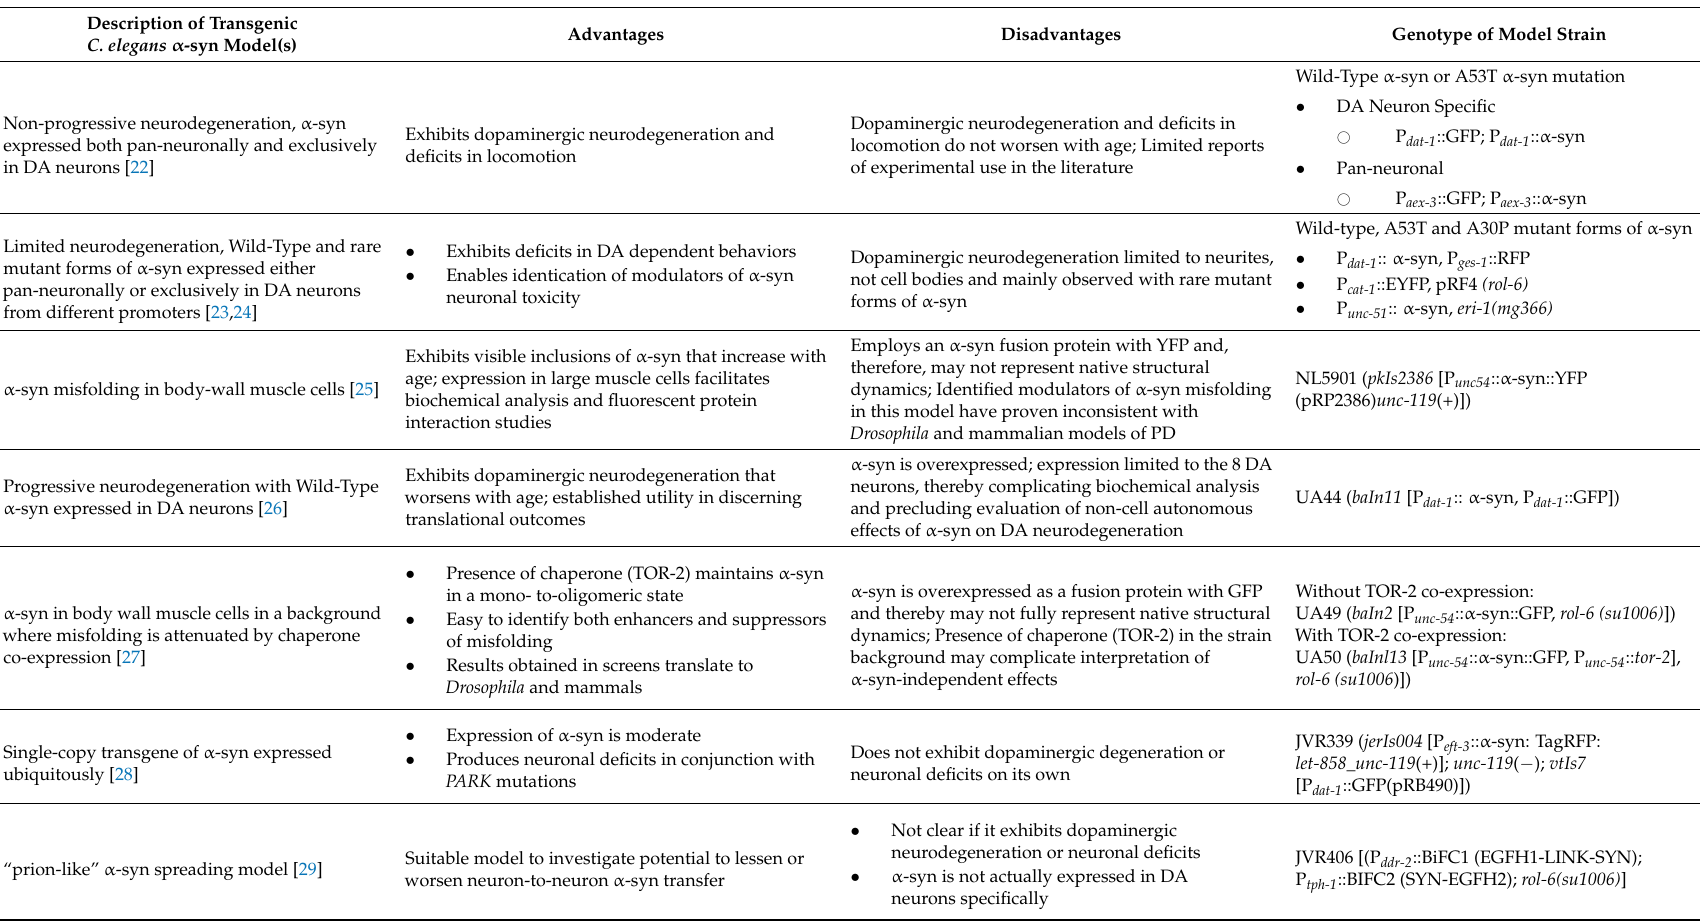
Table 1. This table provides a summary of the advantages, disadvantages and genotypes of the strains used for each α -syn-related C. elegans model of Parkinson’s Disease (PD) detailed in this review. The published article in which each strain was created and first used is referenced below the description of the model. Description of Transgenic C. elegans α -syn